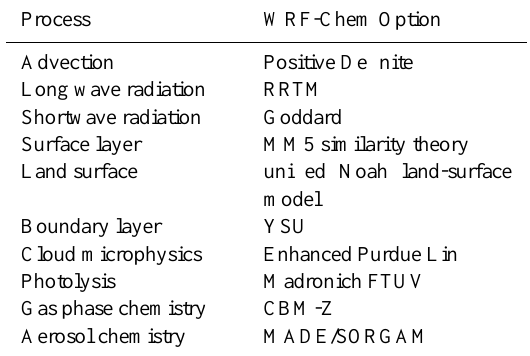
Table 2. Selected WRF-Chem configuration.